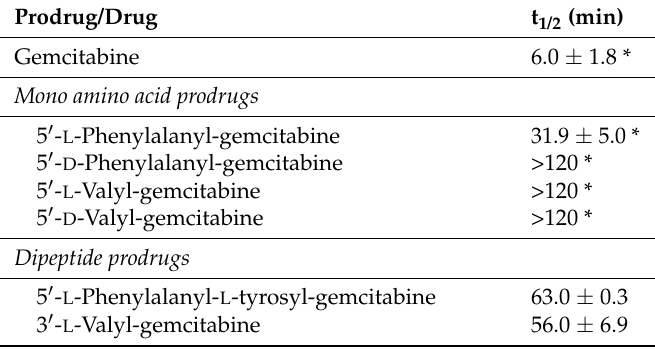
Table 2. Stability of gemcitabine and gemcitabine prodrugs in the presence of thymidine phosphorylase (mean ± S.D., n =